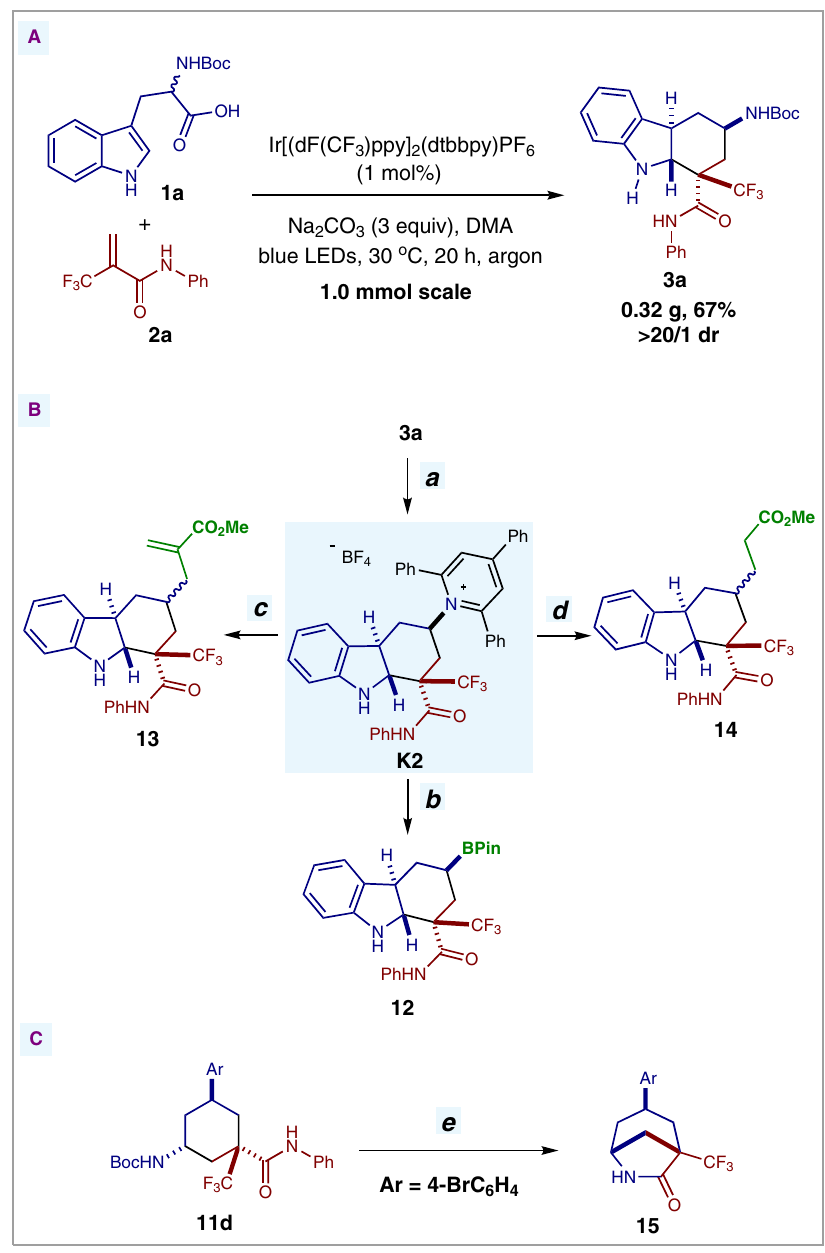
Fig. 9 Synthetic application. A 1.0 mmol-scale reaction. B Synthetic transformations of 3a . C Transformation of 11d . Reaction conditions: [ a ] (i) CF 3